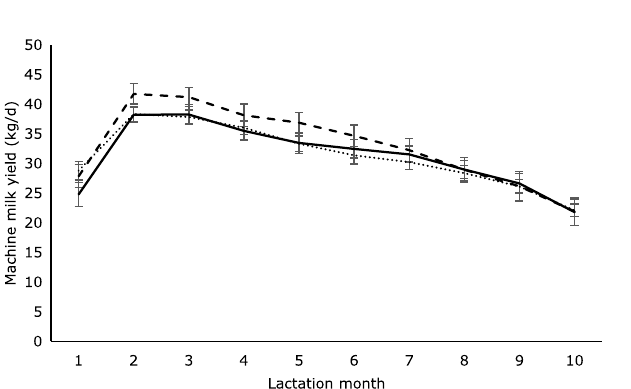
Figure 5. Machine milk yield (mean ± SEM) for the first 10 months of lactation of cows separated from their calves at birth (dotted line), after 2 weeks (dashed line) or after 4 weeks (continuous line). There was no effect of separation time and no interaction between separation time and